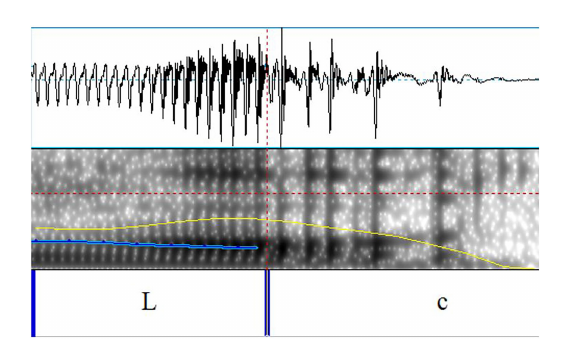
FIGURE 1 An example of the syllable with creaky L tone. Here, L and c stand for the part with periodic and aperiodic